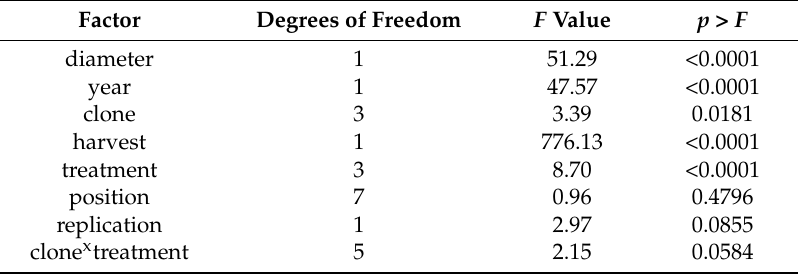
Table 2. The results of the multiple ANOVA analysis ( R 2 = 0.71; p < 0.0001) of the pooled data with biomass (g) as independent variable. The factors in bold are found to be statistically